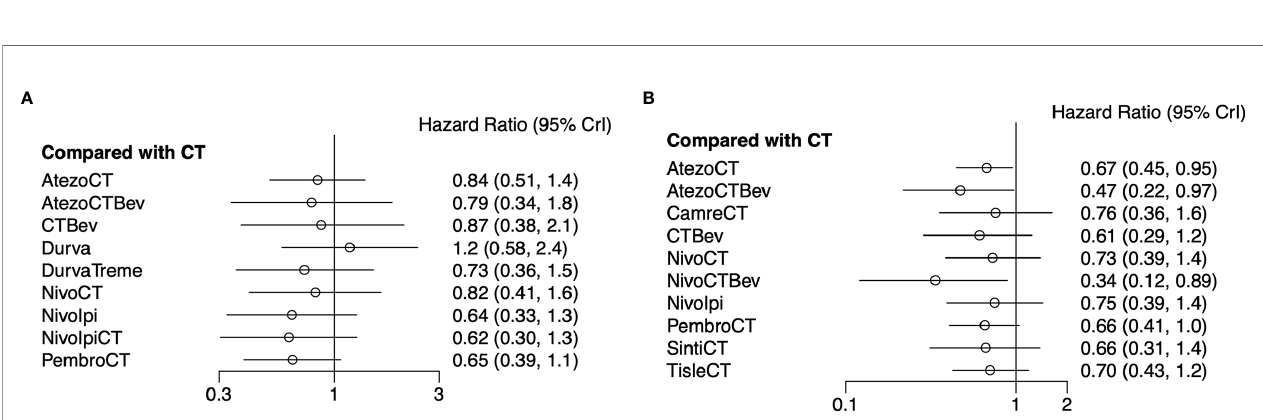
FIGURE 3 | Forest plots showing OS (A) and PFS (B) hazard ratio analyses. Ef fi cacy of 10 and 11 treatment modalities for OS and PFS, respectively. Outcome measure: hazard ratio (HR). PrI, predictive interval; CT, chemotherapy; Atezo, atezolizumab; Bev, bevacizumab; Nivo, nivolumab; Ipi, ipilimumab; Pembro, pembrolizumab; Carem, caremlizumab; Durva, durvalumab; Treme, tremelimumab; Tisle, tislezumab; Sinti, sintilimab; NR, not reported.